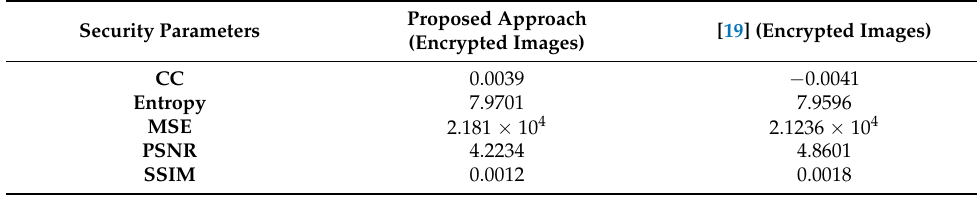
Table 5. Comparison of the proposed approach and [19] for security parameters. Security